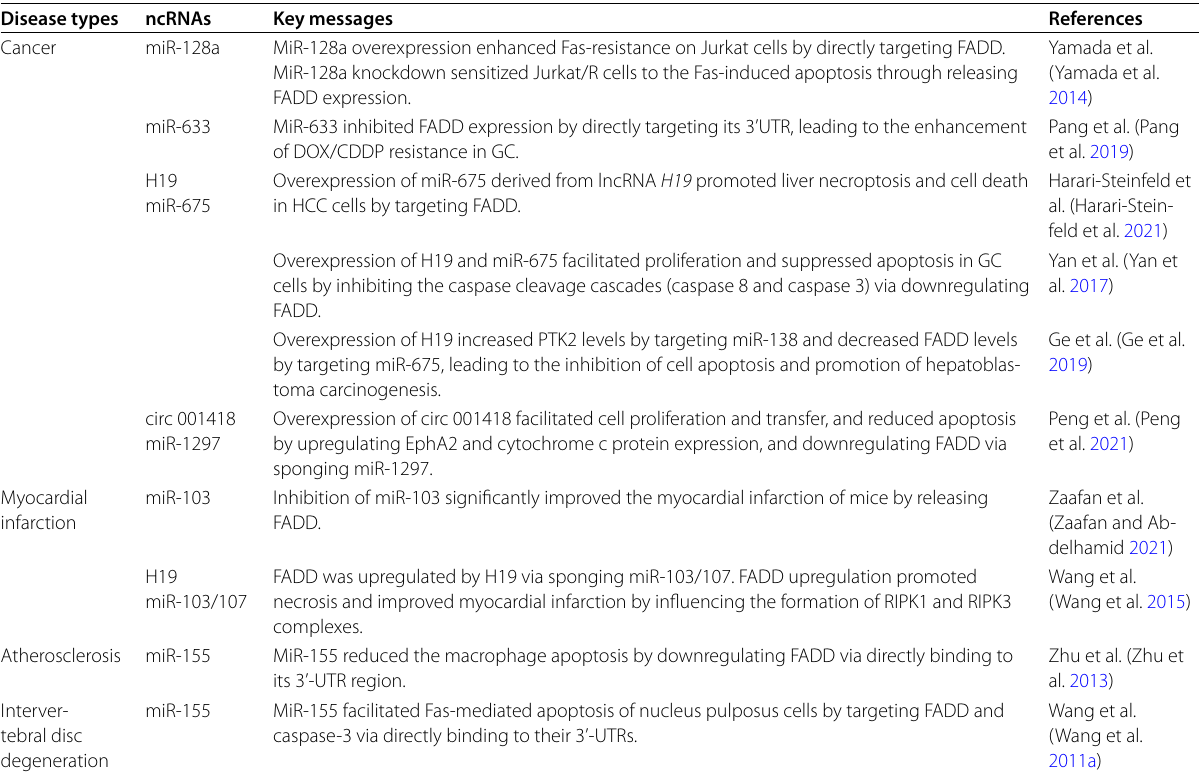
Table 1 NcRNAs targeting FADD in disease Disease